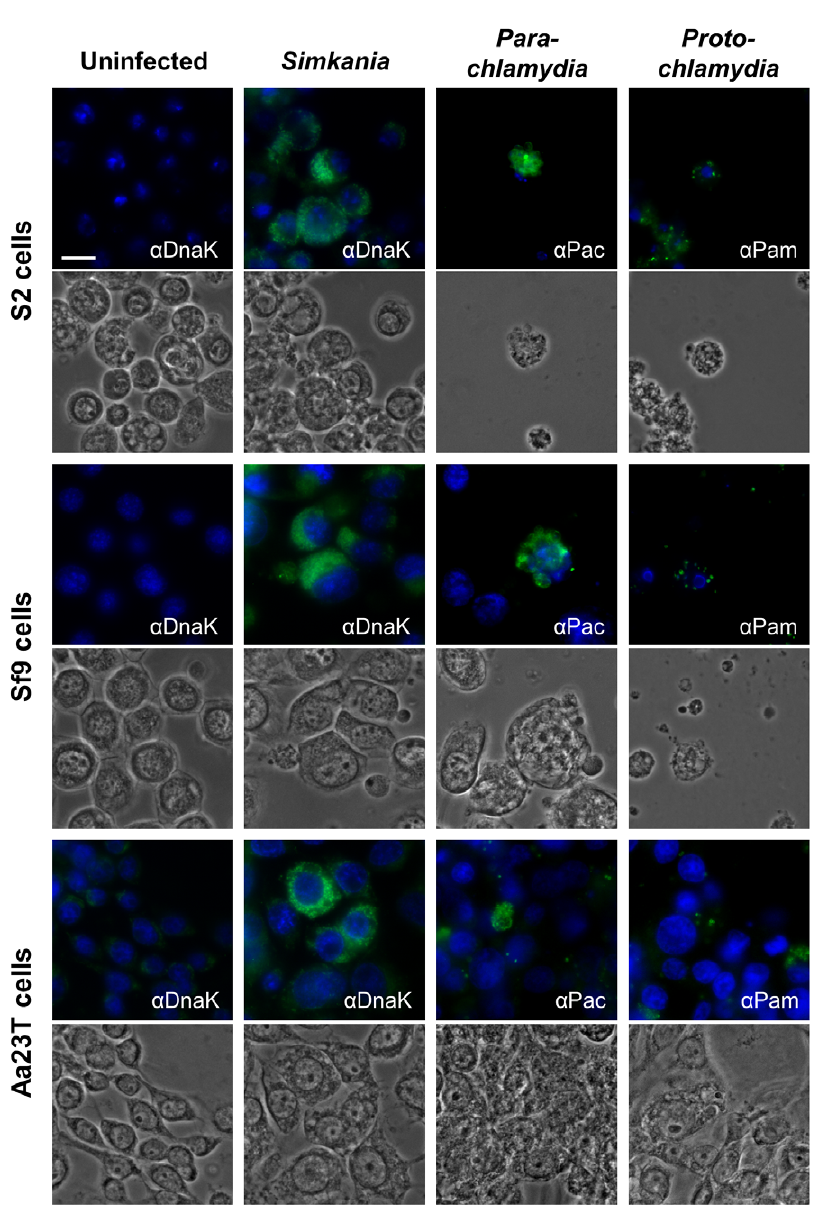
Figure 1. Chlamydial symbionts of amoebae enter and replicate within insect cells. The three insect cell lines S2, Sf9, and Aa23T were either left untreated or were infected with S. negevensis (MOI 40), Pa. acanthamoebae (MOI 1), or P. amoebophila (MOI 5). At 72 h p.i. bacteria were visualized by immunostaining (green) using antibodies raised against the protochlamydial heat-shock protein DnaK ( a DnaK), purified Pa. acanthamoebae UV7 ( a Pac), or purified P. amoebophila UWE25 ( a Pam). DNA was stained with DAPI (blue). The bar corresponds to 10 m